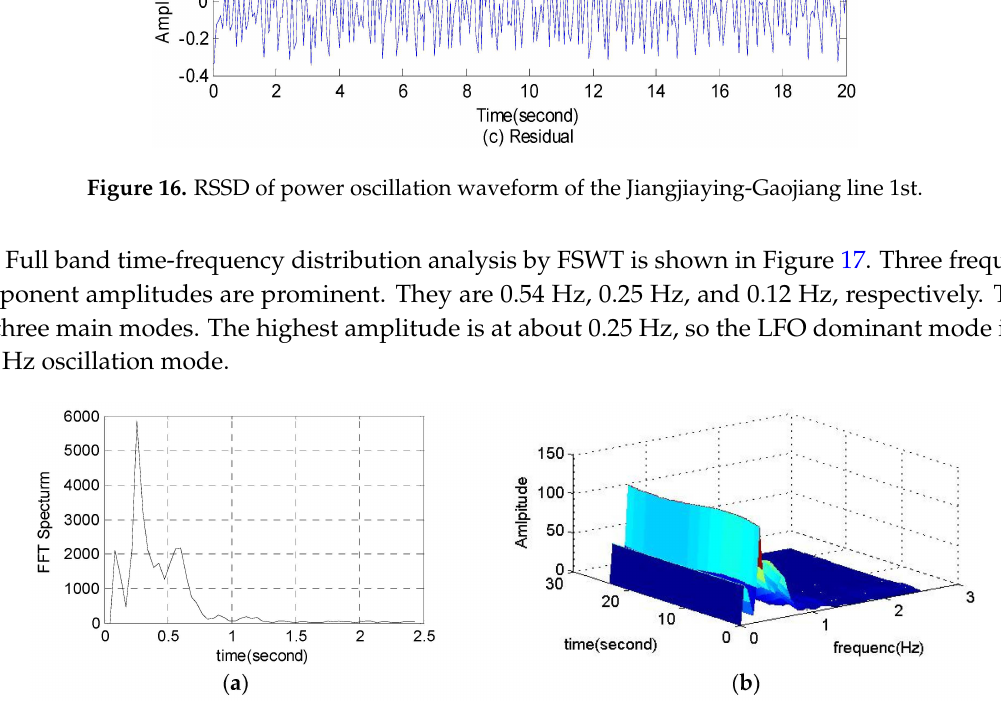
Figure 17. Full band time-frequency distribution analysis by FSWT. ( a ) FFT spectrum; ( b ) FSWT 3D map. Frequency slice intervals are chosen [0, 0.2] Hz, [0.2, 0.5] Hz, and [0.8, 2] Hz, respectively. The shown in Figure 18.